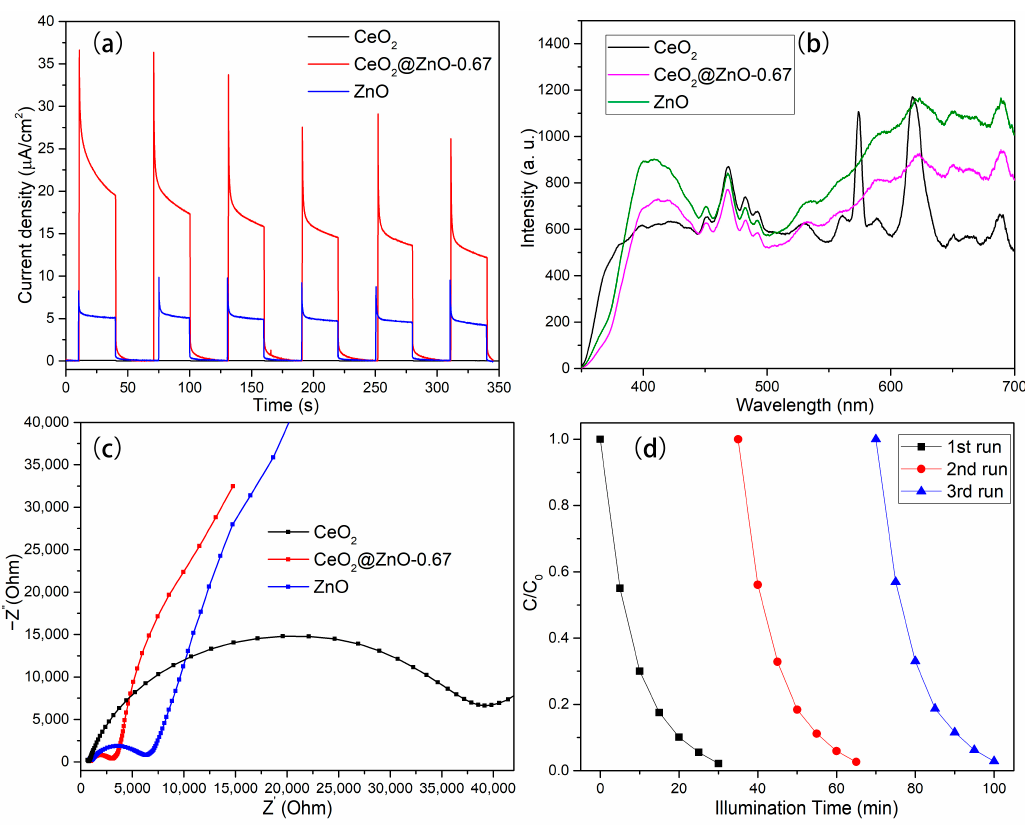
Figure 9. ( a ) Transient photocurrent curves, ( b ) PL spectra, ( c ) and EIS Nyquist plots for CeO, CeO 2 @ZnO-0.67, and ZnO, respectively. ( d ) Cycling experiments of the photodegradation of RhB over CeO 2 @ZnO-0.67.